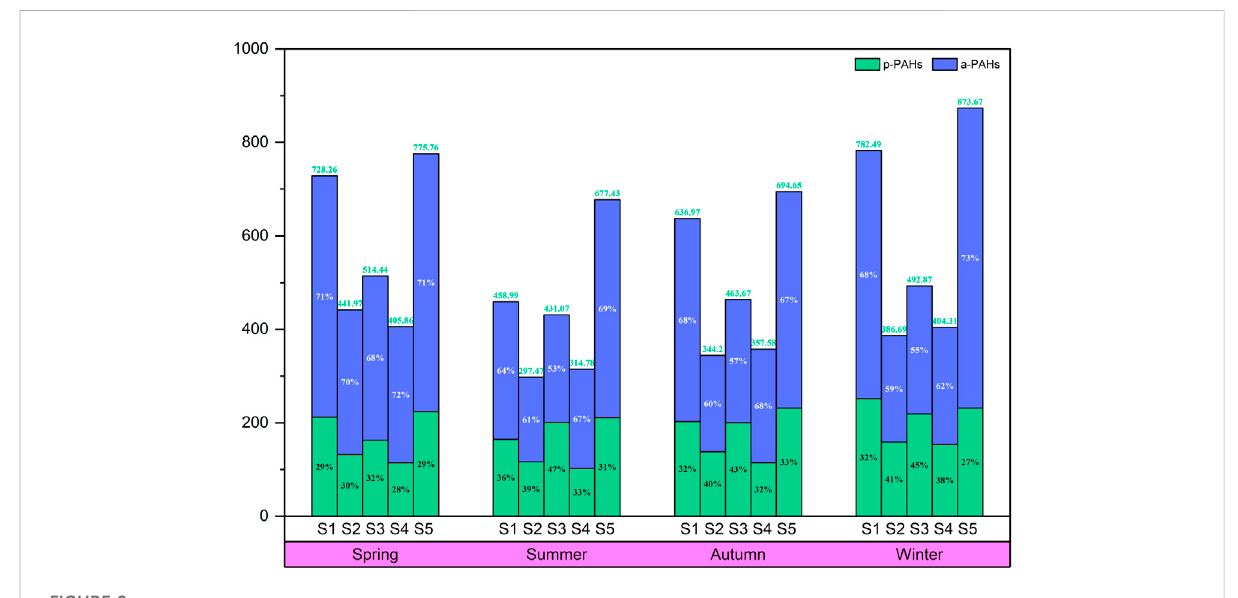
FIGURE 2 Distribution of p-PAHs and a-PAH in karst soils for different